Question: Sum up the contents of this chart in one sentence.
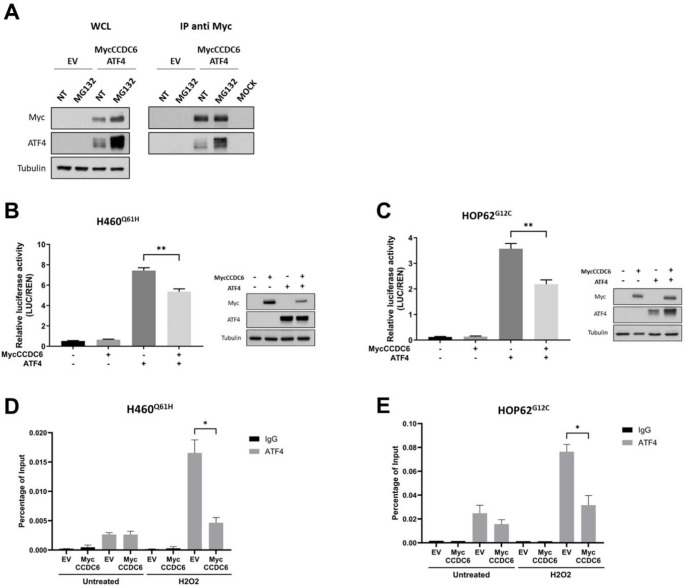
Answer: CCDC6 interacts with ATF4 and negatively regulates its transcriptional activity on the xCT promoter. A 293T cells were co-transfected with MycCCDC6 and ATF4 plasmids, or empty vector (EV) for 48 h and then treated with the proteasome inhibitor MG132 [20 µM] for 4 h. Protein extracts were subjected to immunoprecipitation (IP) with anti-Myc antibody, or with immunoglobulin G (mock) as a control, followed by immunoblotting with anti-Myc and anti-ATF4 antibodies. Total whole cell lysates (WCL), shown on the left, were immunoblotted with the indicated antibodies. B–C Luciferase reporter assay and Western blot analysis in H460 ( B ) and HOP62 ( C ) cell lines. Cells were co-transfected with a firefly luciferase construct containing the xCT promoter and a Renilla luciferase expression construct, in the presence or absence of MycCCDC6 and/or ATF4 plasmids. Firefly and Renilla luciferase activities were determined using the Dual-Luciferase reporter system (Promega). For each sample, the Firefly/Renilla ratio (LUC/REN) is shown as Relative luciferase activity. Transfection efficiency of MycCCDC6 and ATF4 plasmids was evaluated by Western blot analysis using anti-Myc and anti-ATF4 antibodies. Anti-tubulin was used as a loading control. D–E ChiP assay was carried out on H460 ( D ) and HOP62 ( E ) cells transfected with MycCCDC6 or empty vector (EV), as control, and treated with of H2O2 to induce oxidative stress. qTR-PCR was used to determine the percentage enrichment of ATF4 binding on xCT promoter over input. Immunoglobulin G (IgG) was used as a negative control. Where shown, data are reported as mean ± SEM of 3 independent repeats. Statistical significance was verified by 2-tailed Student’s t-test (* p < 0.05; ** p < 0.01)